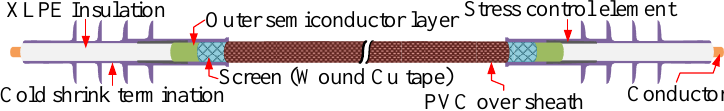
Figure 1. Normal power cable model.